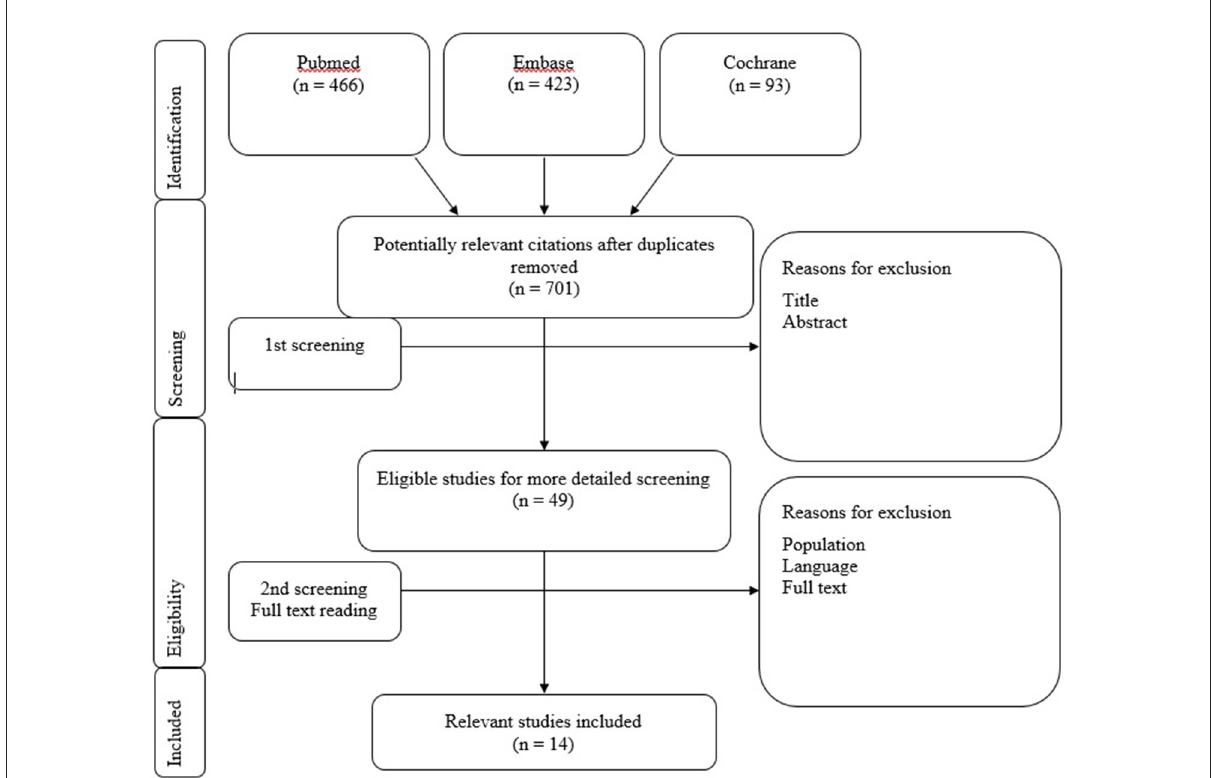
FIGURE1 Flowchart 1: Literature selection procedure. Literature selection procedure. Included studies Jacot et al. (9), Licameli et al. (17), Dhondt et al. (27), Ajalloueyan et al. (28), Devroede et al. (29), Thierry et al. (30), Gupta and Raj (31), Guan et al. (32), Imai et al. (33), Li and Gong (34), De Kegel et al. (35), Xu et al. (36), Psillas et al. (37), and Jin et al.